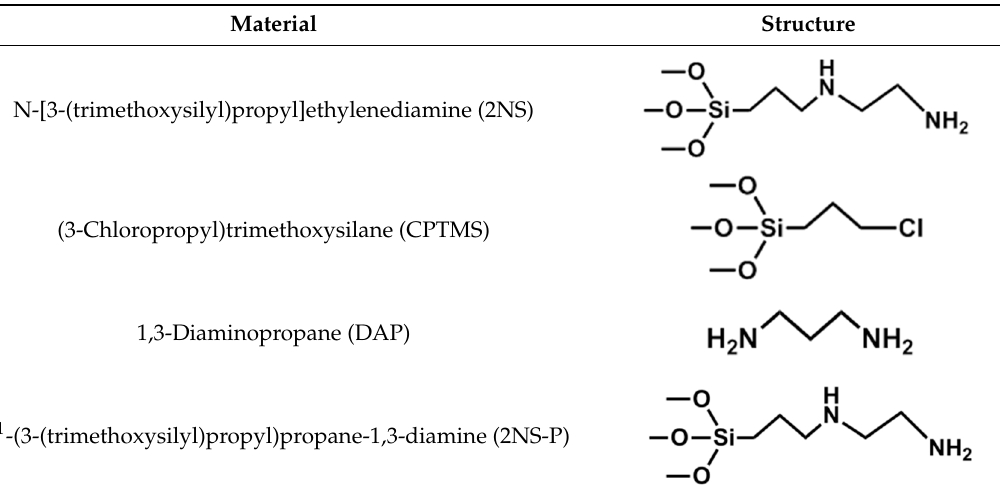
Table 4. Structures of 2NS and the precursors of 2NS-P.